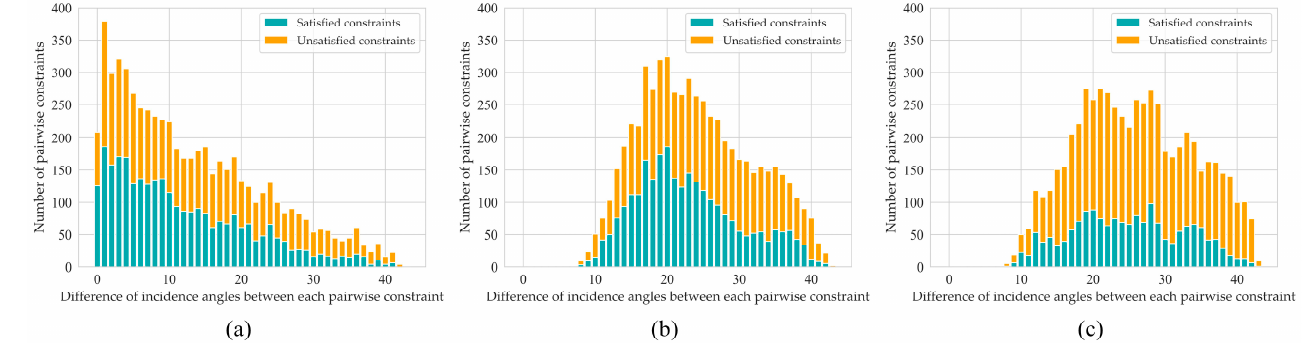
Figure 12. Numbers of satisfied and unsatisfied must-link constraints under the absolute values of the incidence angle differences: ( a ) random sampling; ( b ) RSRIA; ( c )